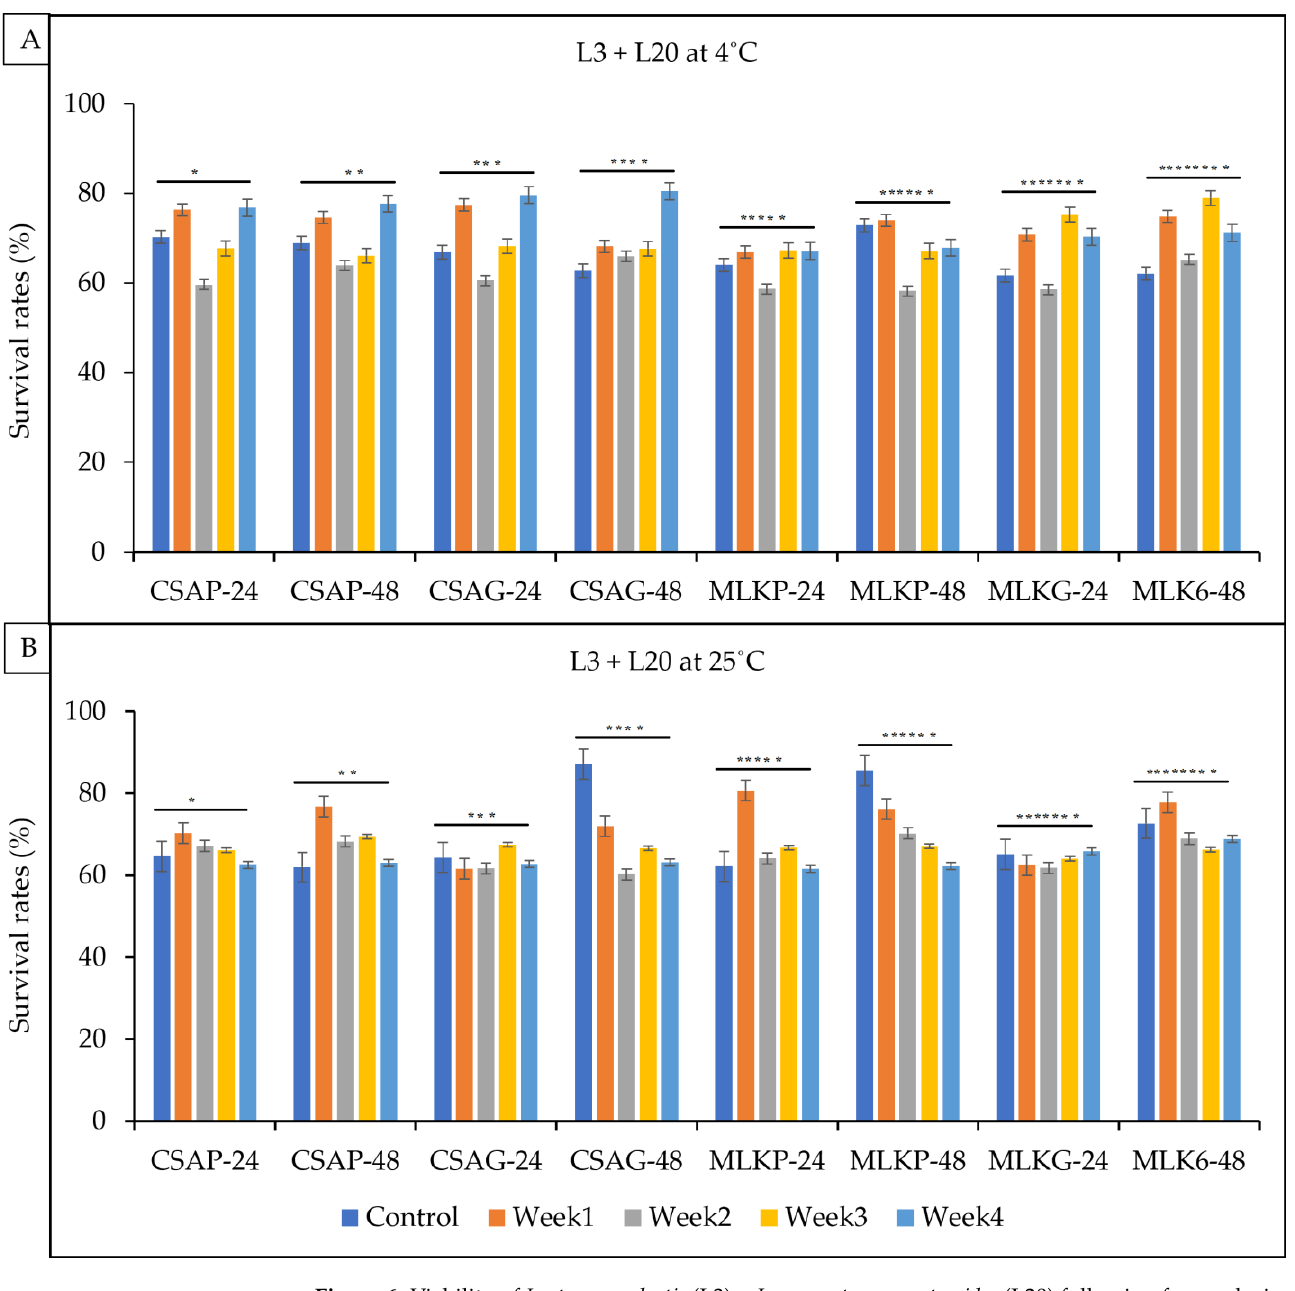
Figure 6. Viability of Lactococcus lactis (L3) + Leuconostoc mesenteroides (L20) following freeze-drying. ( A ) Survival rates at ambient temperature (25 °C), and ( B ) survival rates at refrigerated temperature (4 °C) for 24 h and 48 h. CSAP-24-Cassava in plastic at 24 h, CSAP-48-Cassava in plastic at 48 h, CSAG-24-Cassava in glass at 24 h, CSAG-48-Cassava in glass at 48 h, MLKp-24-Milk in plastic at 24 h, MLKP-48-Milk in plastic at 48 h, MLKG-24-Milk in glass at 24 h, MLKG-48-Milk in glass at 48 h. (Values represent means of three replicate experiments, ±: standard deviation). For ( A ) * p -value = 0.35322, ** p -value = 0.24439, *** p -value = 0.06101, **** p -value = 0.00014, ***** p -value = 0.27411, ****** p -value = 0.00294, ******* p -value = 0.00228, ******** p -value = 0.00001. For ( B ) * p -value = 0.02542, ** p -value = 0.00010, *** p -value = 0.09876, **** p -value =